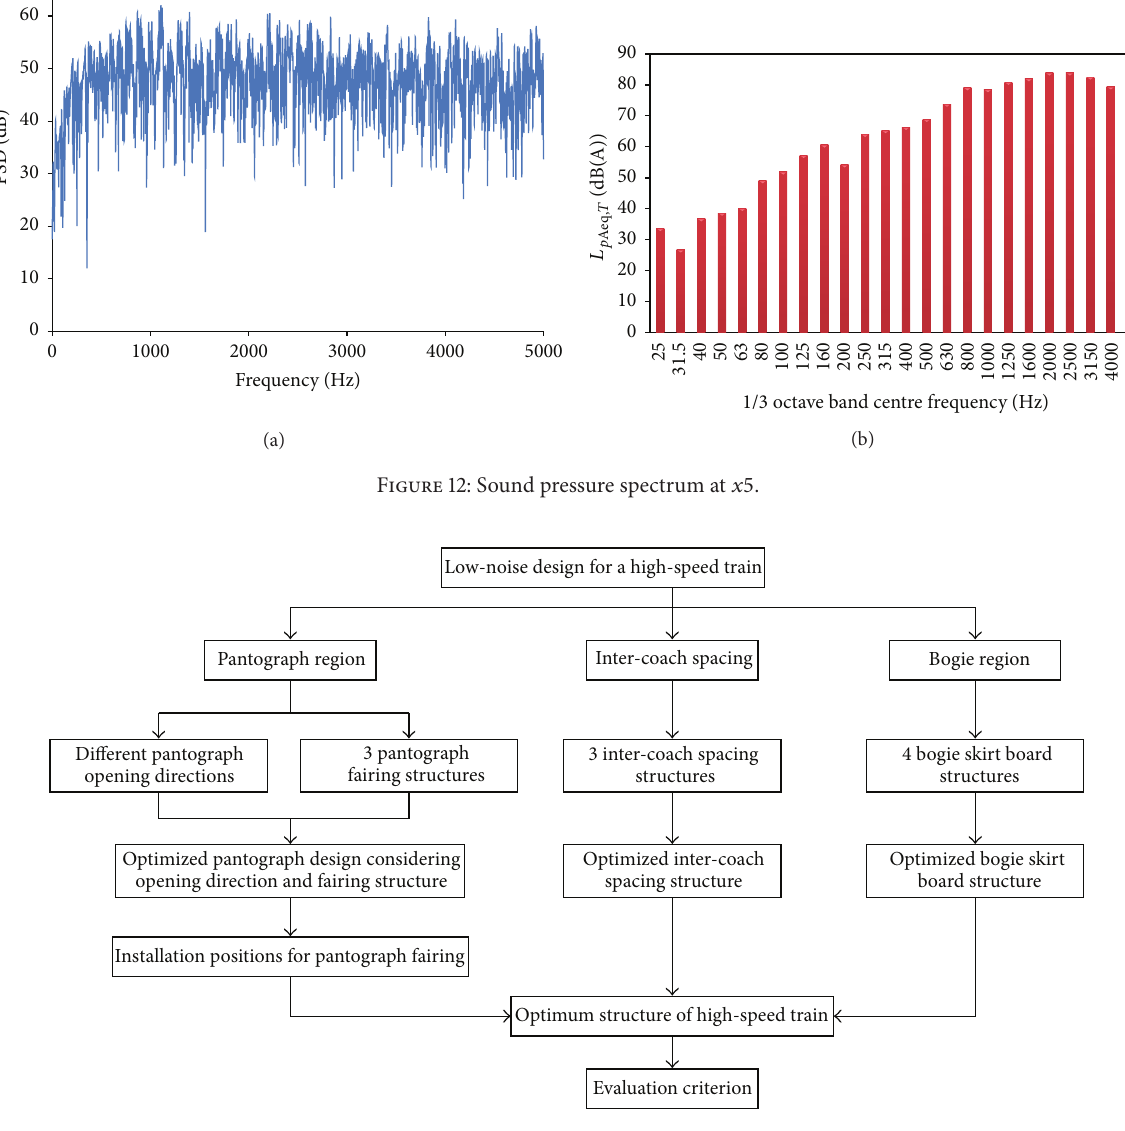
Figure 13: Flow chart of the low-noise design process for a high-speed